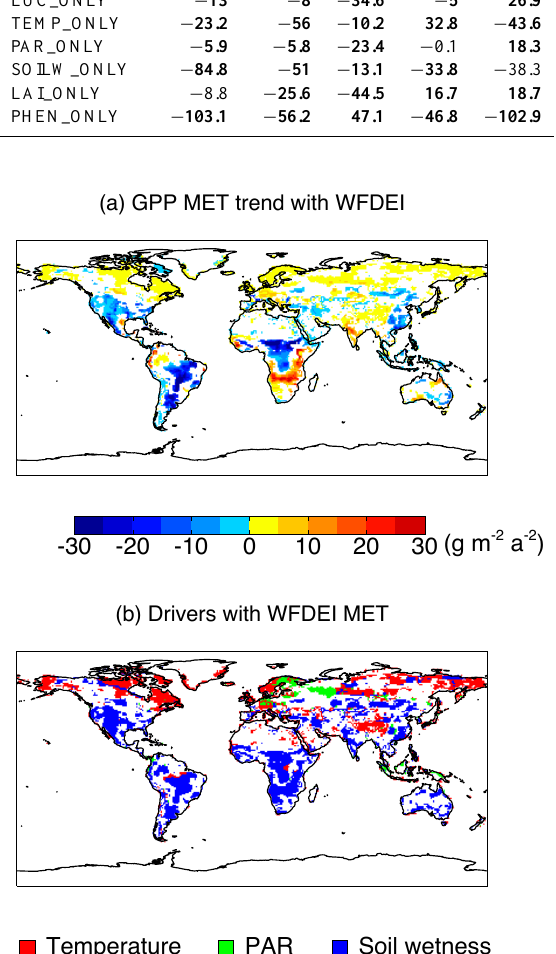
Figure 4. Simulated (a) trends in GPP driven alone with WFDEI reanalysis and the (b) drivers for such changes. Simulation in (a) is performed with year-to-year meteorological forcings but prescribed [CO 2 ] and land use in the year 1980. Simulations in (b) are the same as (a) except that the year-to-year variations are allowed only for a single meteorological variable (temperature, PAR, or soil wetness) each time. For each grid, the meteorological variable generating the largest (either maximum or minimum) trend with the same sign as the net change (a) is selected as the driving factor. Only significant trends ( p < 0 . 05) are presented.